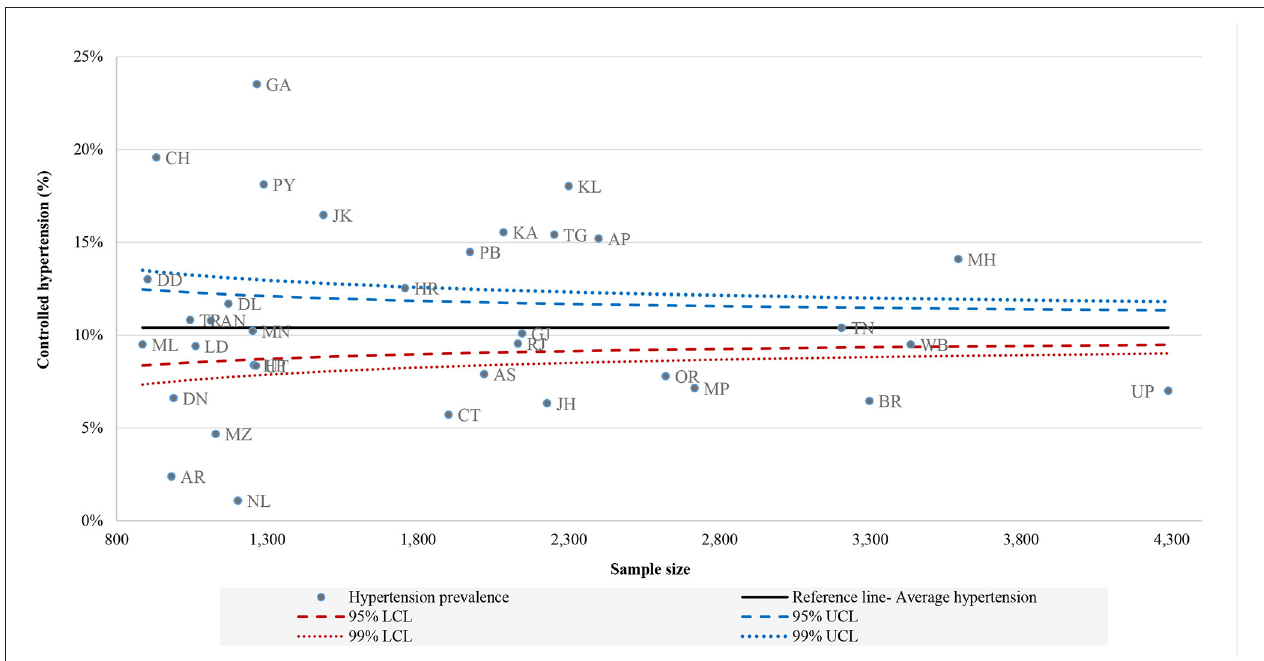
FIGURE 3 | Funnel plot of performance of states: controlled hypertension, LASI (2017–18).